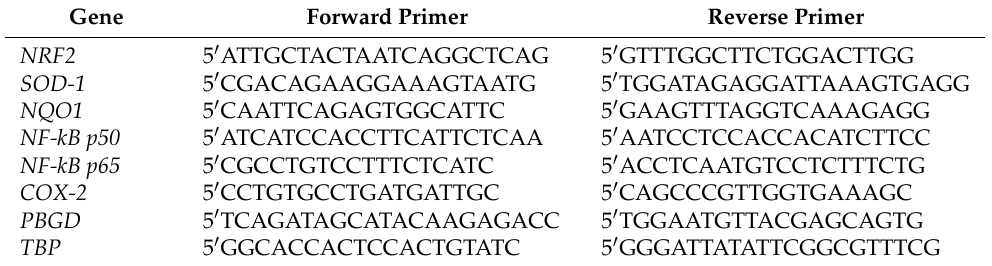
Table 5. Primers used in R-T